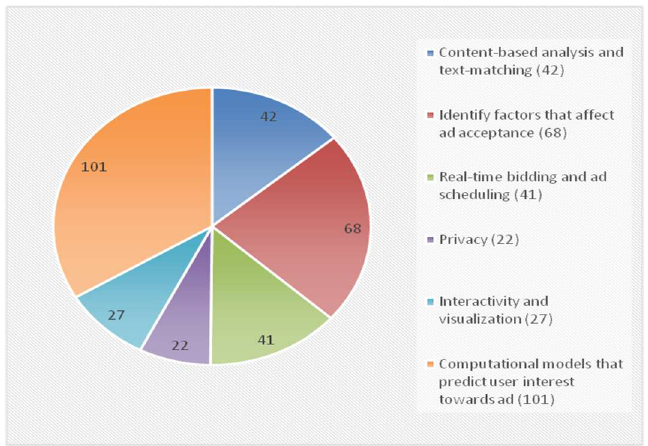
Figure 4. Number of works regarding each